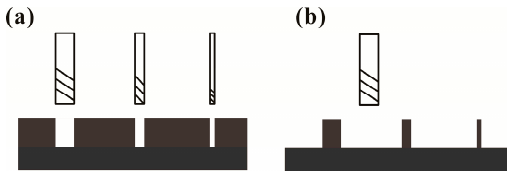
Figure 2. Advantage of positive master. ( a ) Different width of negative master milled by variable dimension of end mill; ( b ) Different width of positive master milled by only one dimension of end mill.